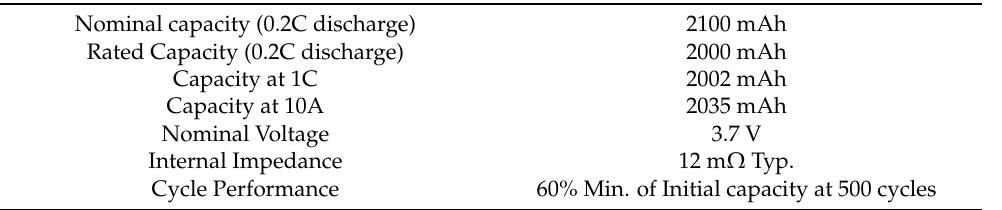
Table 1. Li-ion battery specification